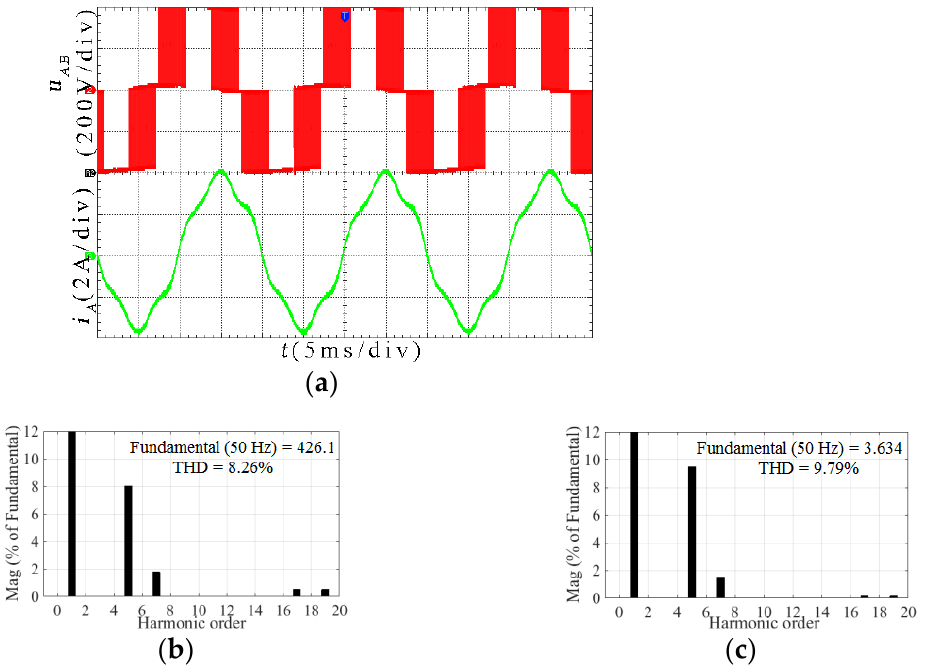
Figure 16. Experimental results for the HSOS at m = 0.615. ( a ) Line voltage u AB and line current i A ;